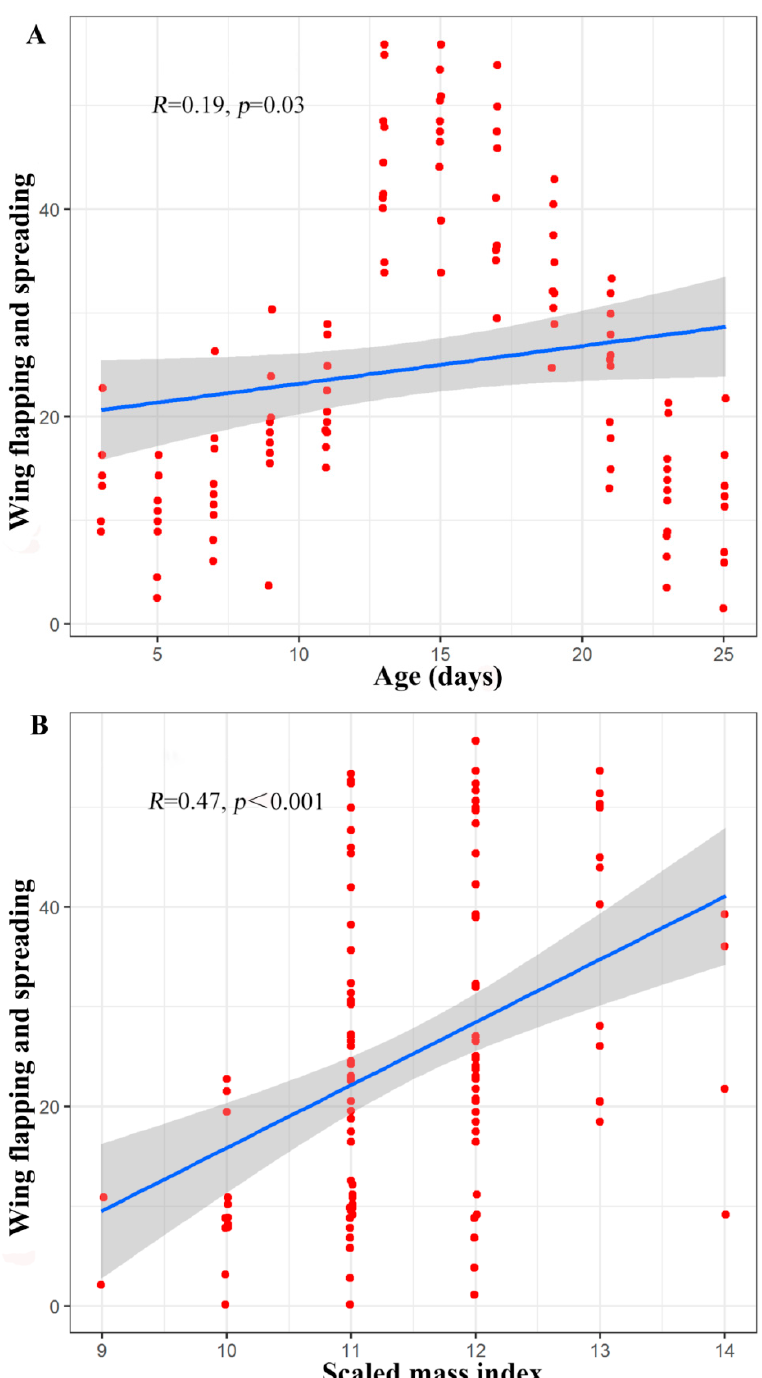
Figure 6. ( A ) Scatter plot of the partial correlation between age and number of occurrences of the wing spreading and flapping behaviours in young Asian parti-coloured bats ( Vespertilio sinensis ). ( B ) Scatter plot of the partial correlation between the scaled mass index and number of occurrences of the wing spreading and flapping behaviours in young Asian parti-coloured bats ( Vespertilio sinensis ). The solid blue lines represent the fitted curves, and the shadowed areas represent the 95% confidence interval. The flight experiments began when the bats were 17 days old, and there was a sequence of ages at which the individuals made their first flights (first successful flight, first failed landing). The time between the first flight and the acquisition of flight capability (successful flight, successful landing) varies between individuals (Table S2).